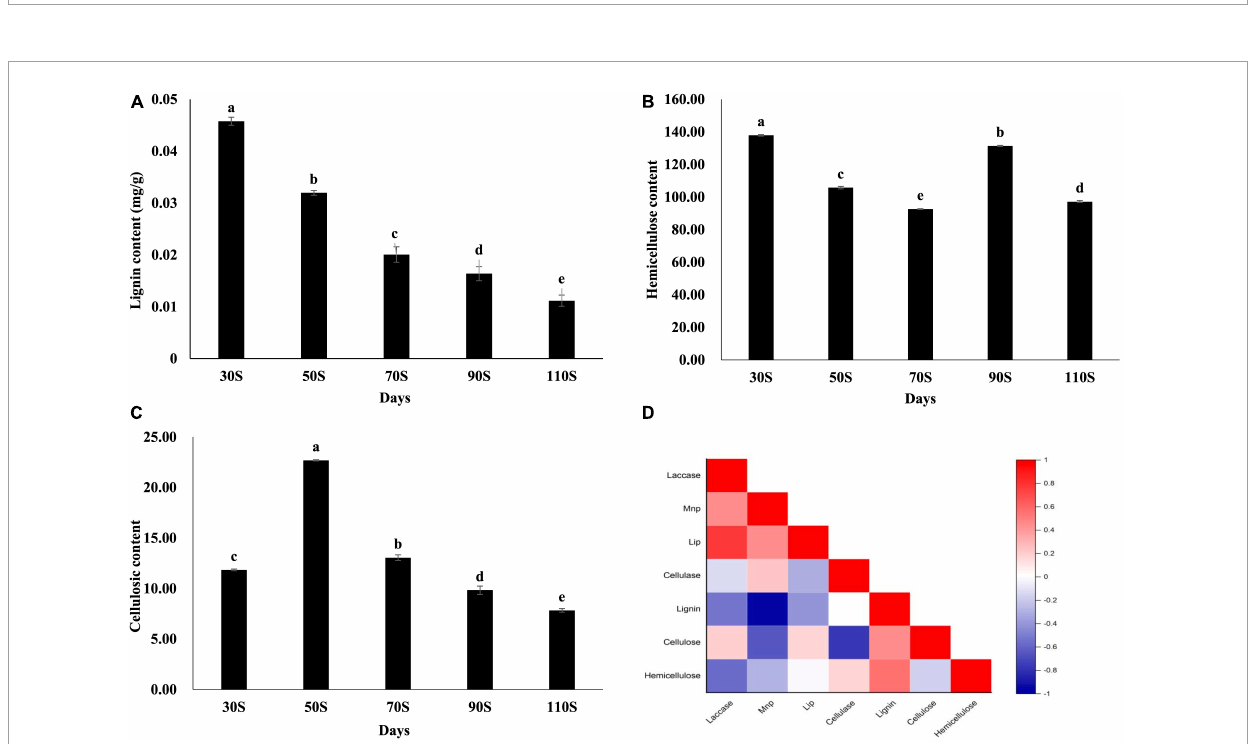
FIGURE8 Contents of lignin (A) , cellulose (B) , hemicellulose (C) , and results of correlation analyses (D) . Pearson correlations coefficients were evaluated between contents and enzyme activities. Red represents a positive correlation, and blue represents a negative correlation ( p < 0.05). The intensity of the color represents the significance level. Values are the means of three replicates ± SD. Different letters above columns indicate statistically significant differences between individual nutrient content at p < 0.05 (ANOVA-LSD, n =